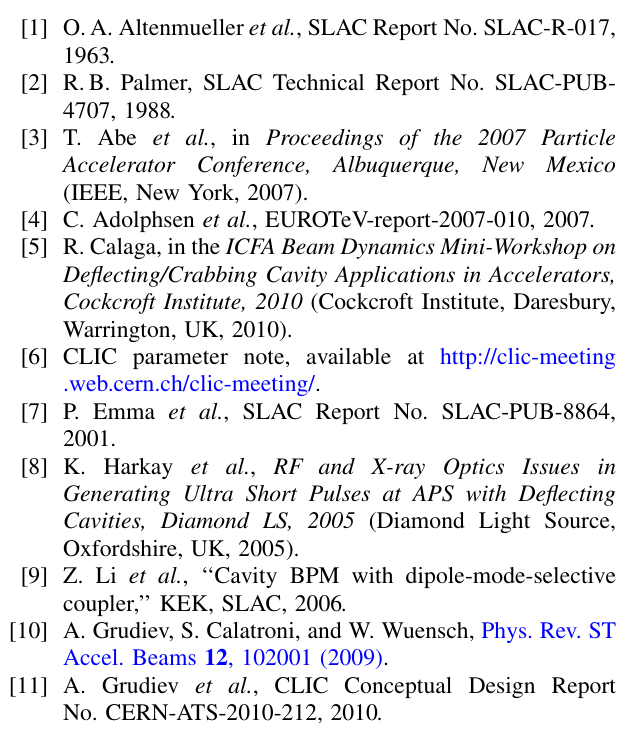
FIG. 22. Vertical kick for the metal plate loaded TE ¼ 1 V . cavity for V crab